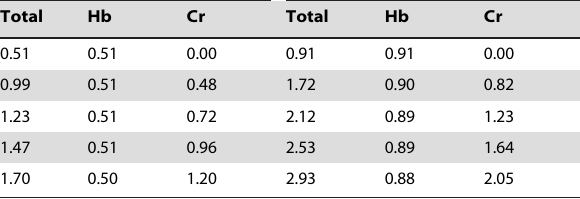
Table 2. Average m a (450–600 nm) of liquid phantoms containing hemoglobin, crocin, and polystyrene